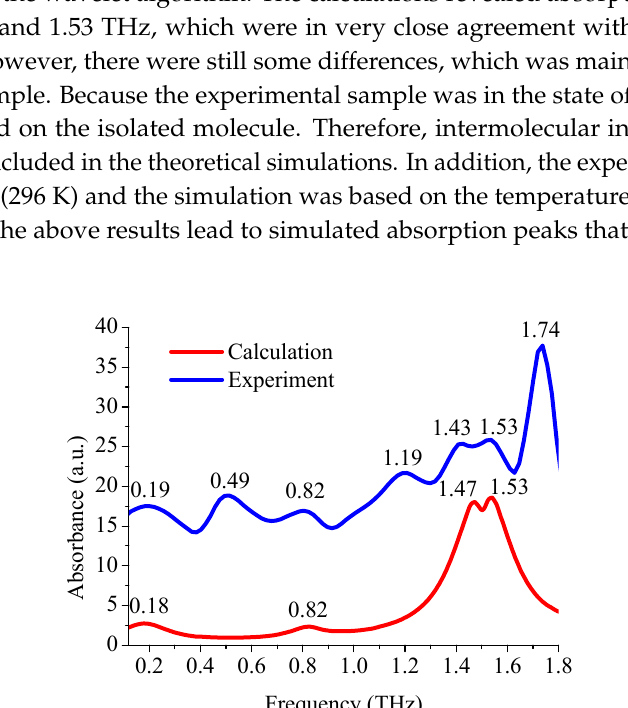
Figure 6. Comparison of theoretical and experimental spectra of the paper (the experimental spectra vertically displaced by 10 a.u.).